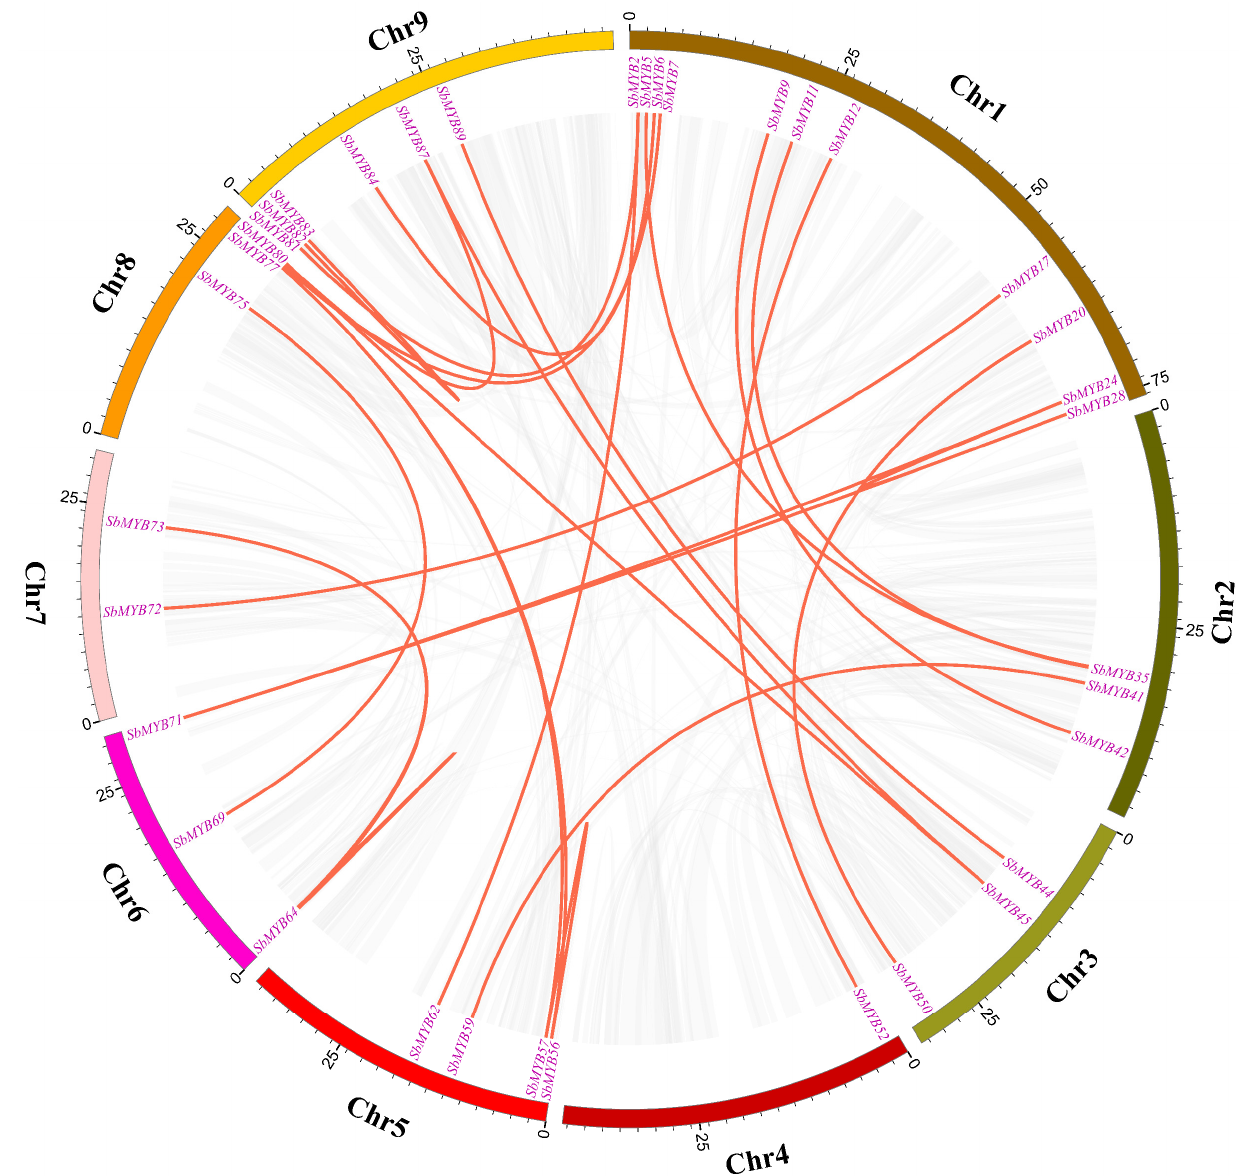
Figure 4. Interchromosomal relationships of the R2R3-MYB genes in S. baicalensis . Synteny blocks in S. baicalensis are depicted in gray lines, and duplicate MYB gene pairs are shown in red lines.